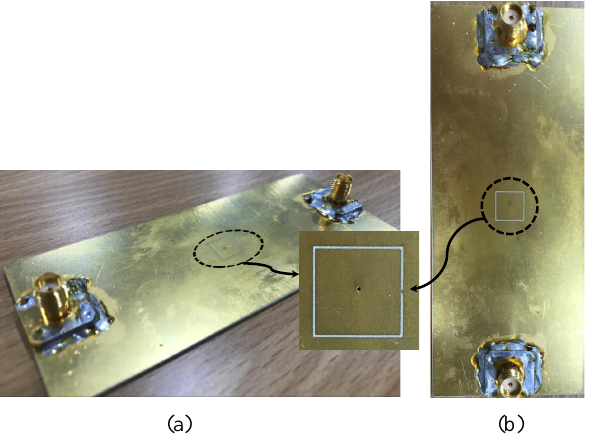
Figure 12. The fabricated CSRR sensor with a via. ( a ) Perspective view. ( b ) The top